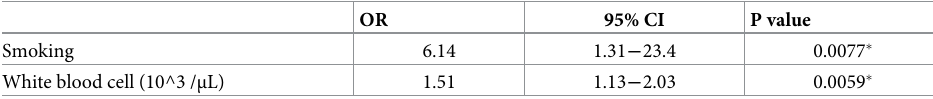
Table 2. Multivariate analysis of prognostic factors for